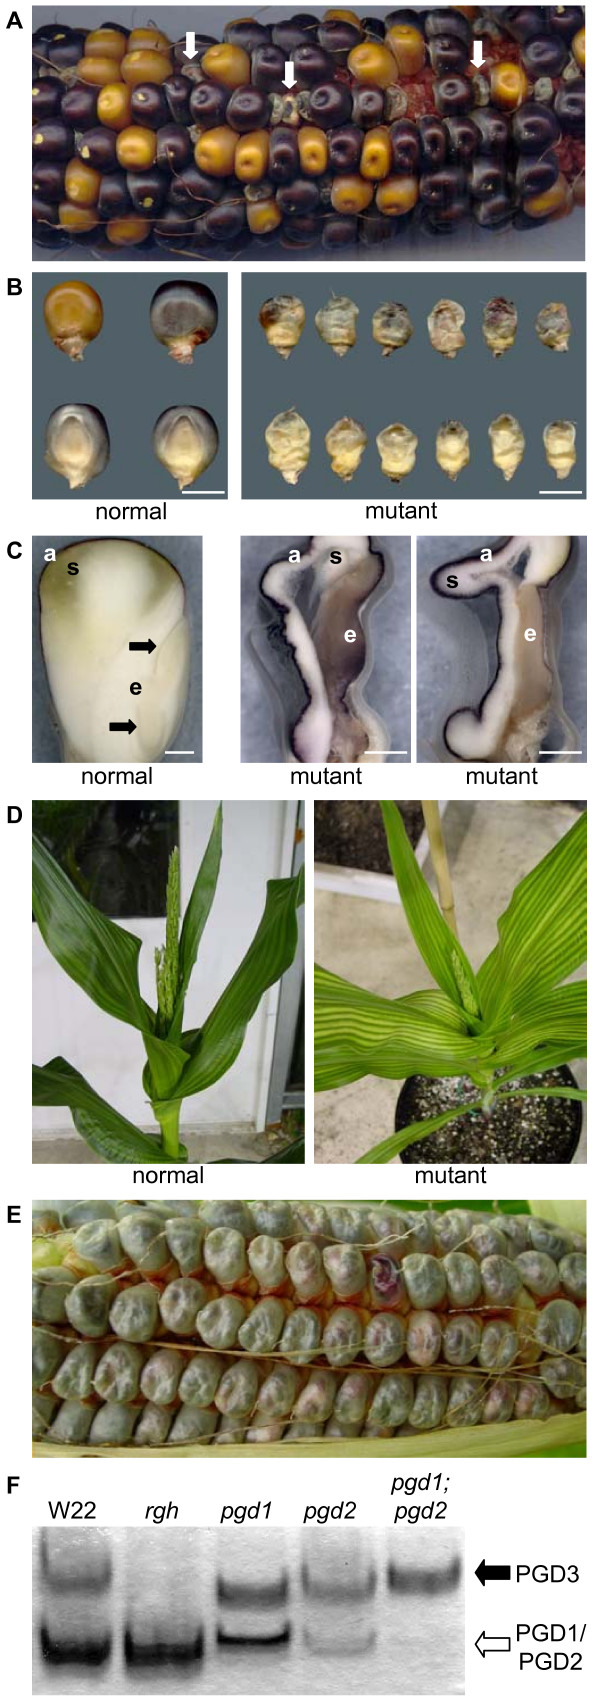
Phenotype of the rgh*-00S-005-14. (A) Self-pollinated ear segregating for rgh kernels (arrows). (B) Mature normal and rgh sibling kernels. The top row shows the abgerminal side of the kernels, and the bottom row shows the germinal side of the kernels. Scale bars are 5 mm. (C) Longitudinal hand sections of normal and rgh kernels. Aleurone, starchy endosperm, and embryo tissues are denoted by a, s, and e, respectively. Arrows indicate embryonic shoot and root tissues in the normal kernel. Scale bars are 1 mm. (D) Normal and rgh mutant plants 50 days after initiating tissue culture. (E) Homozygous rgh mutant ear at 35 DAP. (F) Native PAGE assay for 6PGDH activity from 25 DAP endosperm extracts. Black arrow indicates the inferred PGD3 isozyme and the open arrow indicates the PGD1 and PGD2 homo- and heterodimer isozymes.